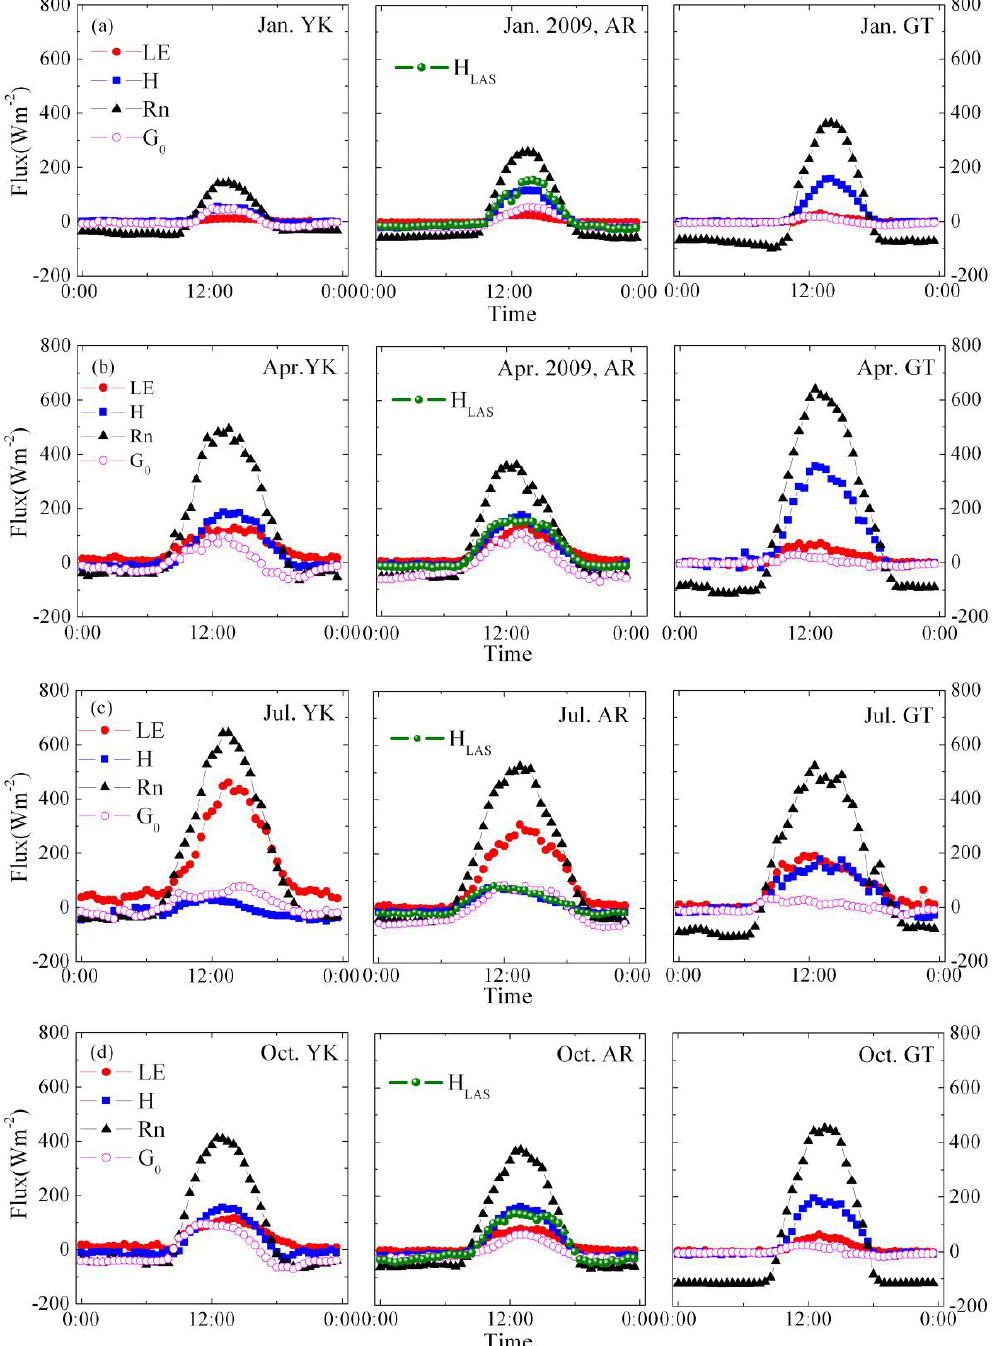
Fig. 5. Seasonal variations in the averaged diurnal course of energy fluxes over different surfaces in 2008 (January and April 2009 at AR) (Beijing standard time, BST)